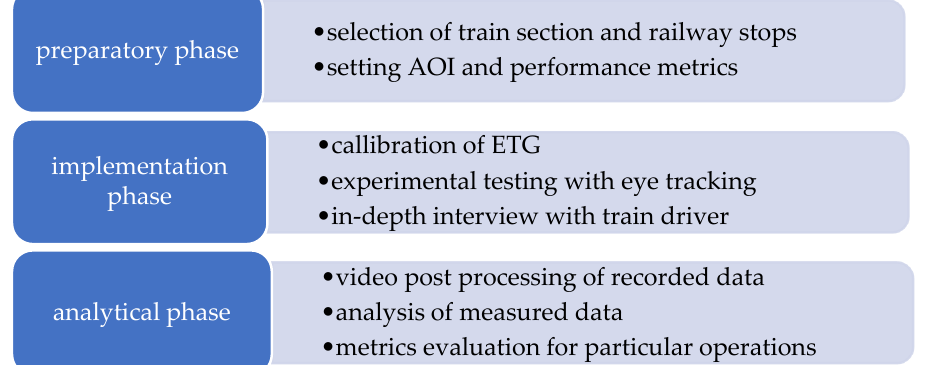
Figure 1. Methodology of research.